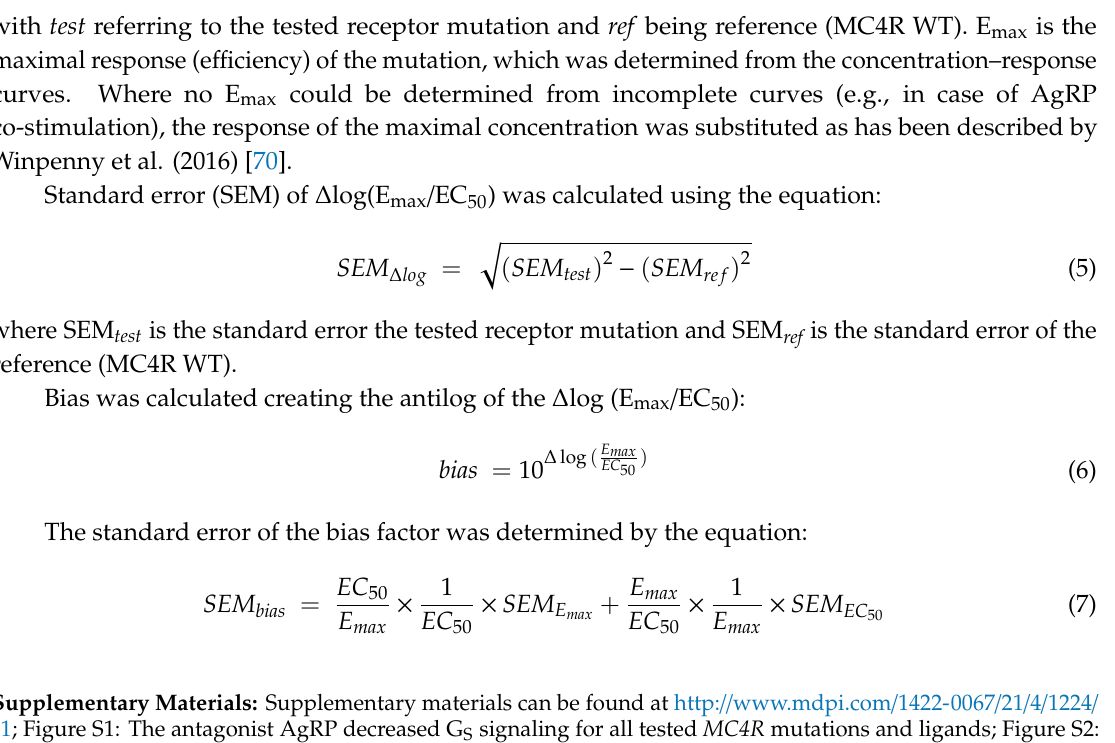
s1; Figure S1: The antagonist AgRP decreased G S signaling for all tested MC4R mutations and ligands; Figure S2: Contributions from G i / 0 coupling was determined by measuring the PTX-sensitive cAMP accumulation; Table S1: Quantification of endosomes from the confocal images; Table S2: Basal, e ffi cacy, potency and bias values of activation of G S signaling and β -arrestin2 recruitment of MC4R mutations V103I, S127L and H158R; Table S3: Basal, e ffi cacy, potency and bias values of activation of G i / 0 and G q / 11 signaling of MC4R mutations V103I, S127L and H158R; Table S4: Basal, e ffi cacy, potency and bias values of activation of G 12 / 13 and ERK phosphorylation of MC4R mutations V103I, S127L and H158R; Table S5: Primer sequences for introduction of mutations V103I, S127L and